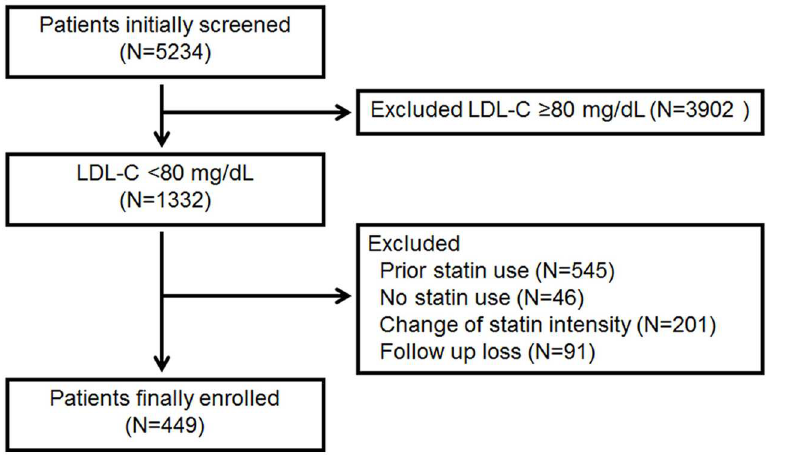
Fig 1. Patient screening, exclusion, and